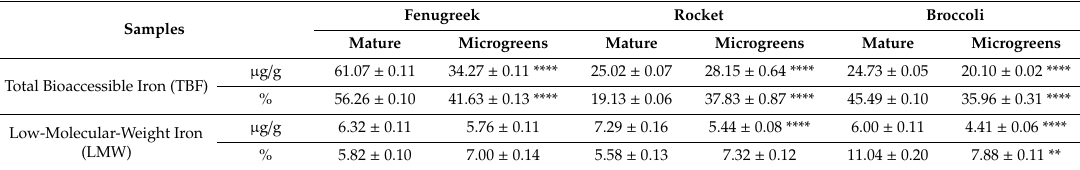
Table 2. Total bioaccessible and low-molecular-weight iron in digest